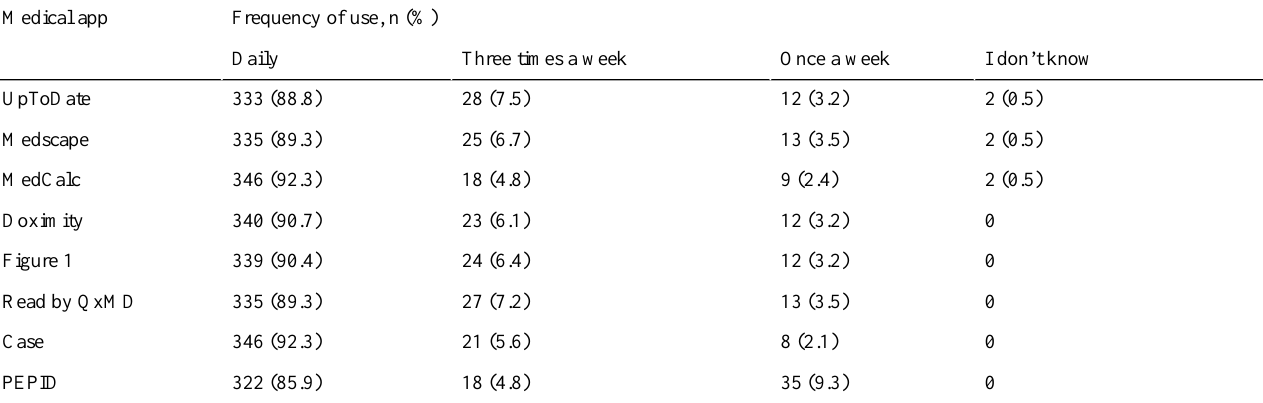
Table 5. Frequency of smartphone medical app use among physicians working at referral hospitals of Amhara regional state, 2019 (N=375). Frequency of use, n (%)Medical